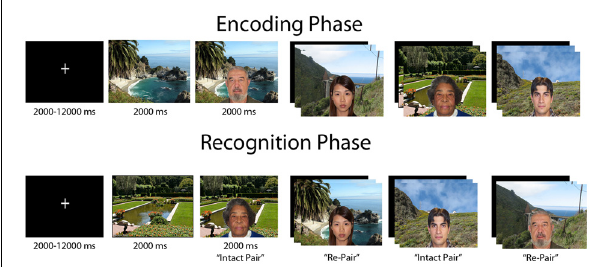
FIGURE 1 | Figural depiction of encoding and recognition phases of relational memory task. Each trial consisted of a jittered inter-trial-interval, followed by a scene preview and then the face overlaid on the scene. In a block, each phase consisted of 24 trials, with a 20s break in between encoding and recognition. Participants completed three blocks of the